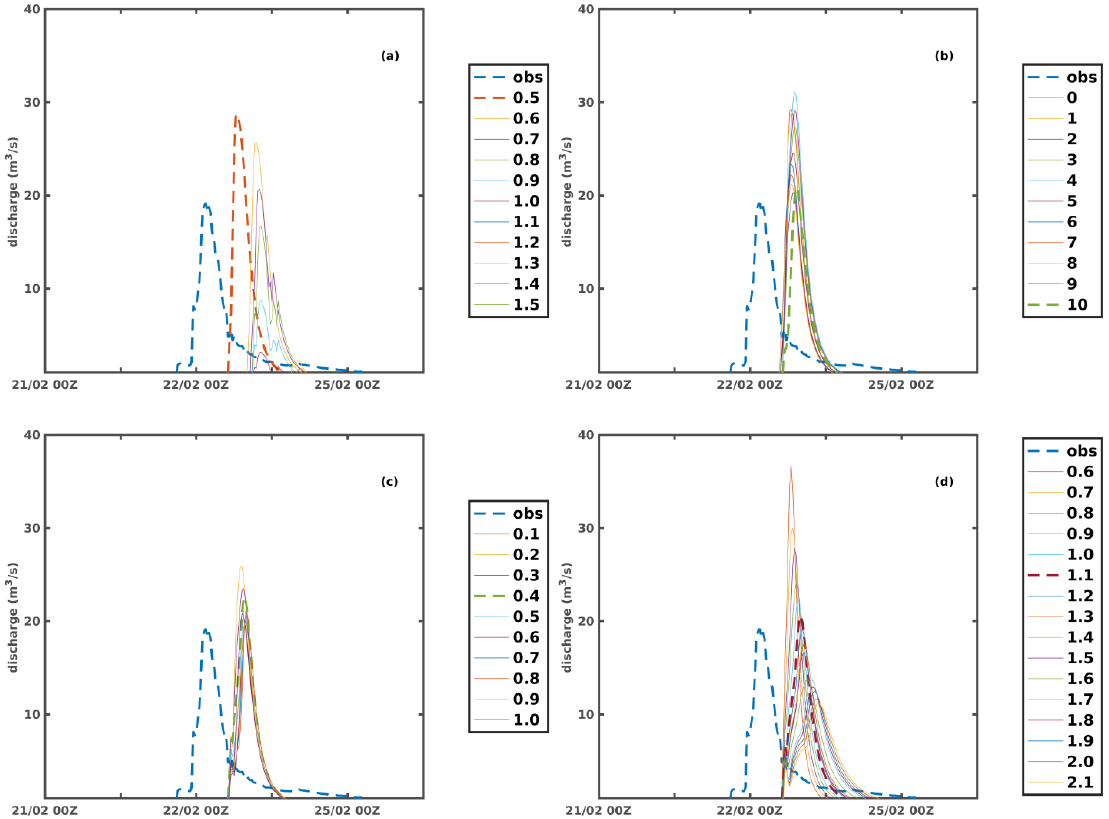
Figure 3. The evolution of the discharge (observed and simulated) for event 5 for (a) REFKDT, (b) RETDEPRTFAC, (c) OVROUGHRTAC, and (d) MannN parameter.